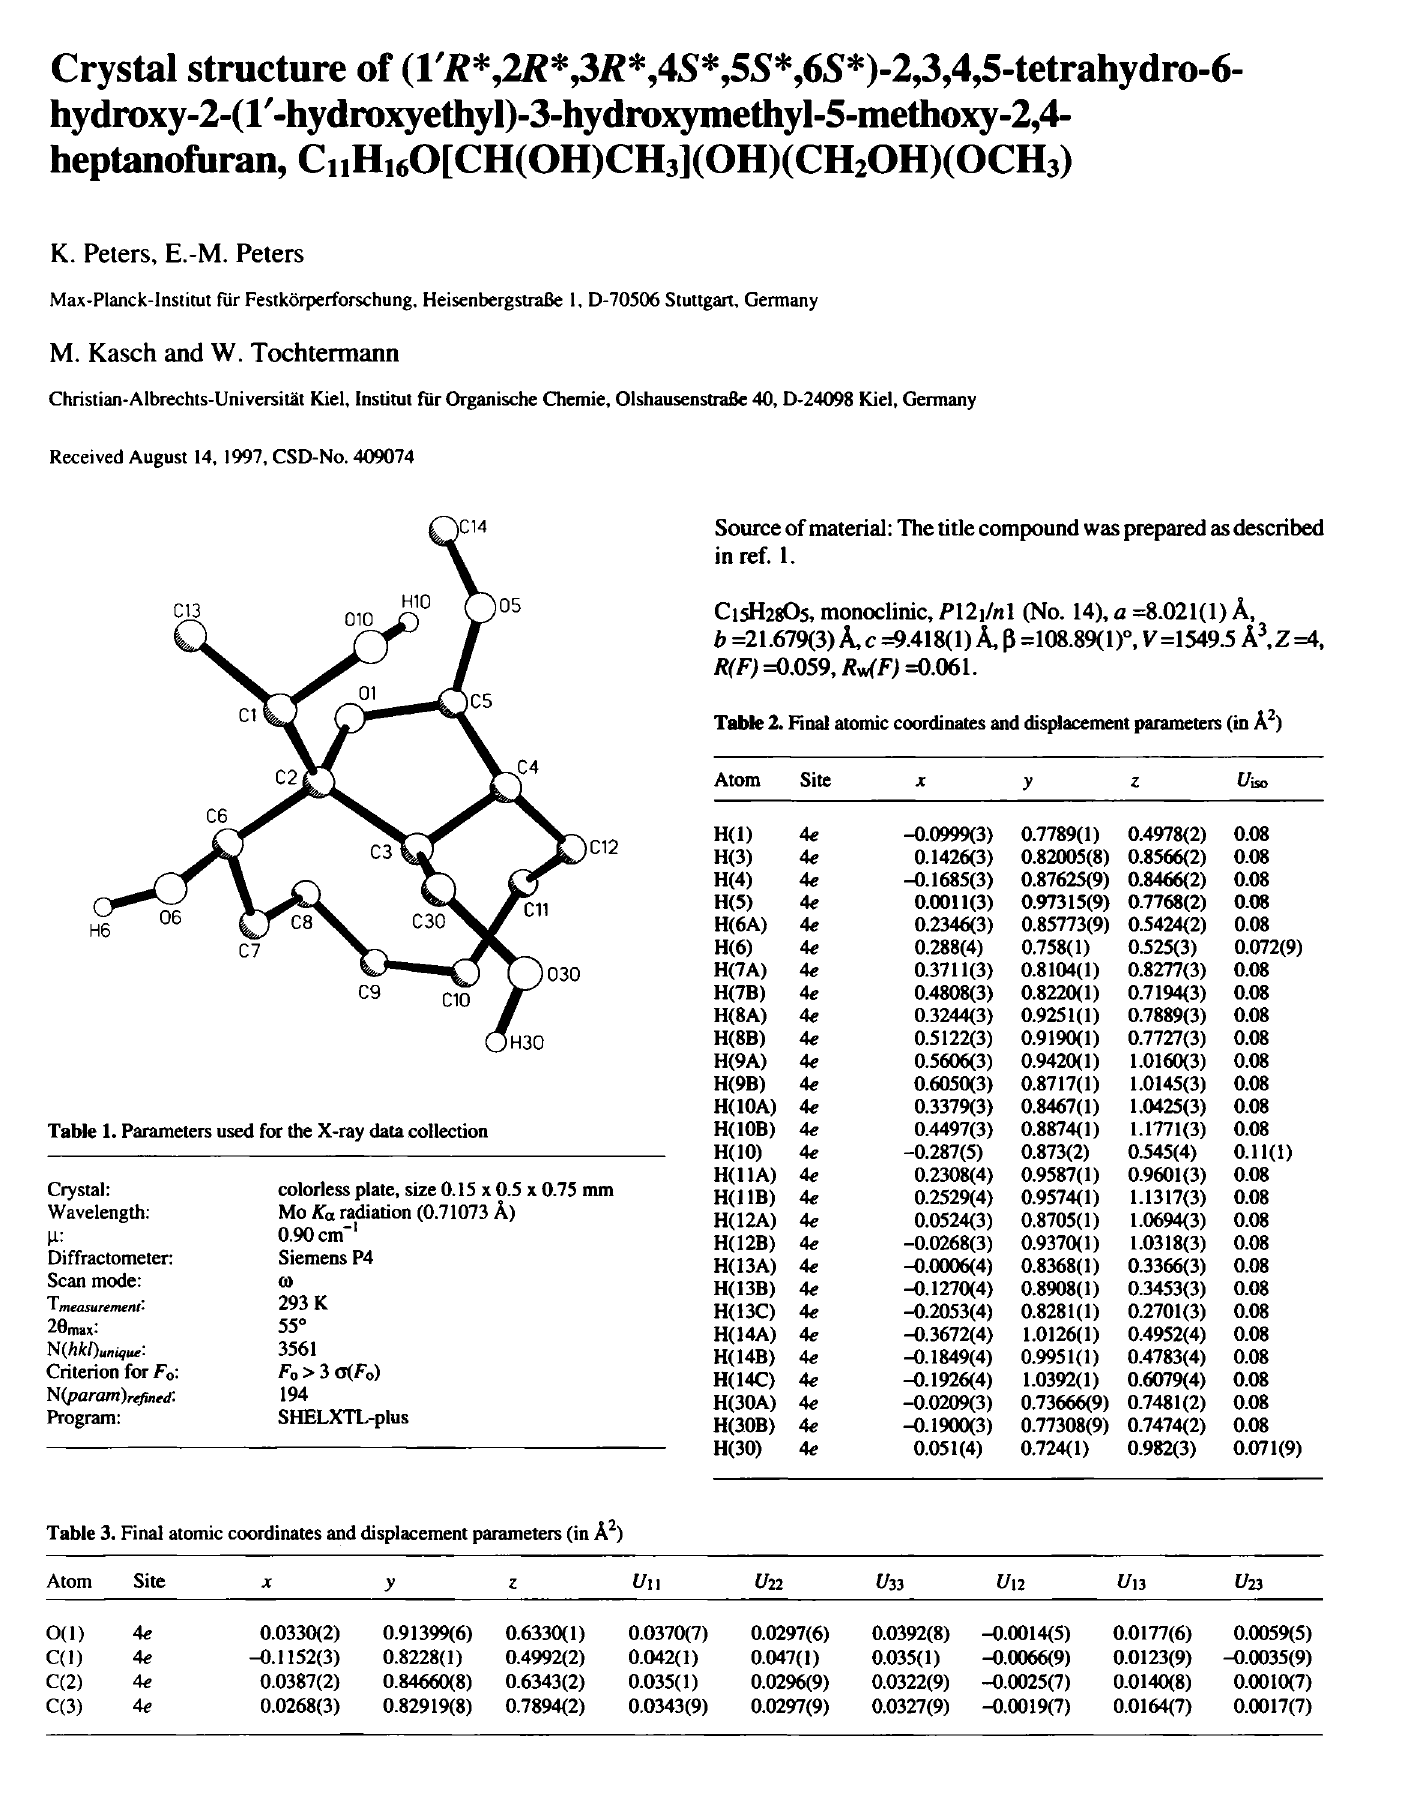
Table 3. Final atomic coordinates and displacement parameters (in Â^) Atom